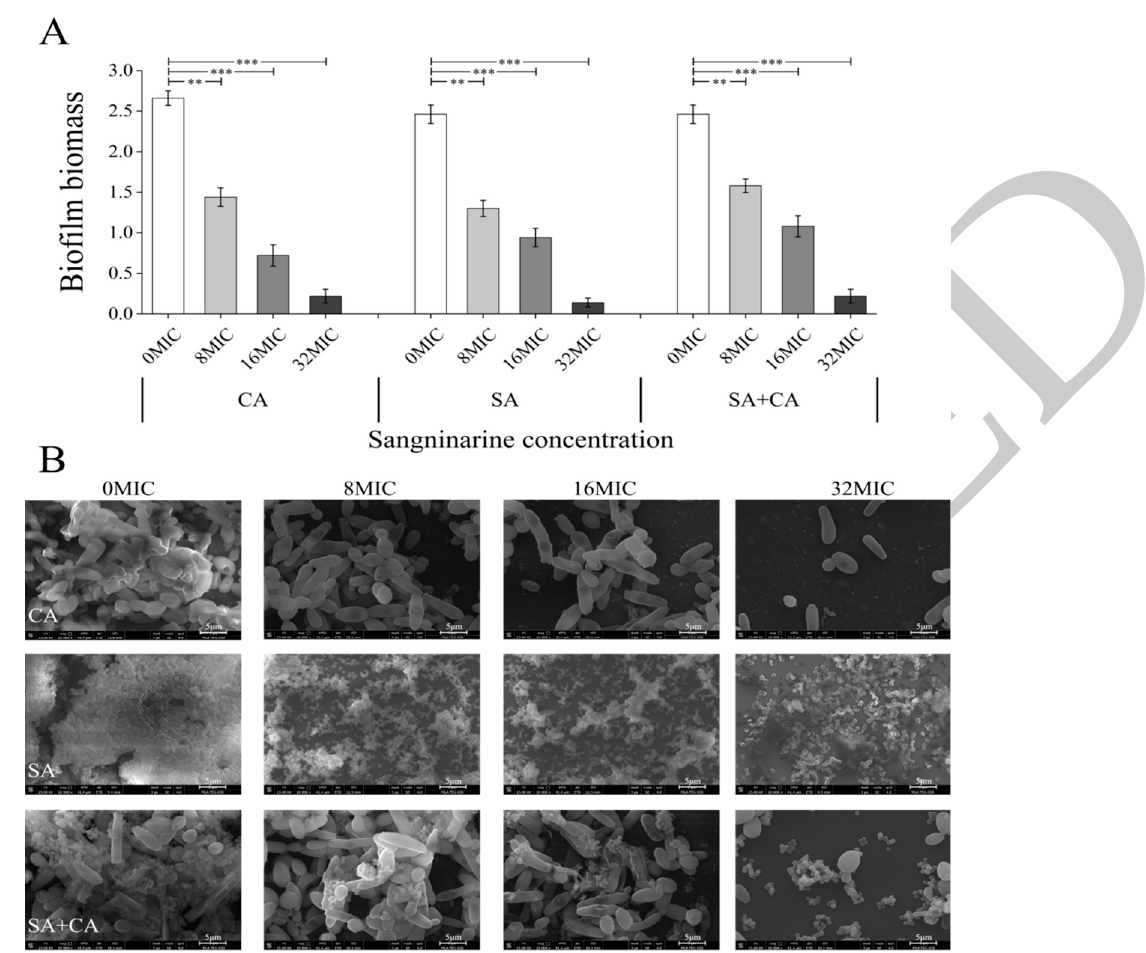
Figure 7. Eradication effects of different concentrations of sanguinarine on mature biofilms of C. albicans SC5314 and S. aureus CMCC26003 mono- and dual-species by crystal violet assay ( A ) and field emission scanning electron microscopy ( B ), respectively. The biofilm biomass was determined using the crystal violet assay. Values represent the means of triplicate measurements. Bars represent the standard deviation (N = 6). ** p < 0.01; *** p < 0.001. Each field of vision was magnified 10,000×. Scale bars represent 5 μ m.